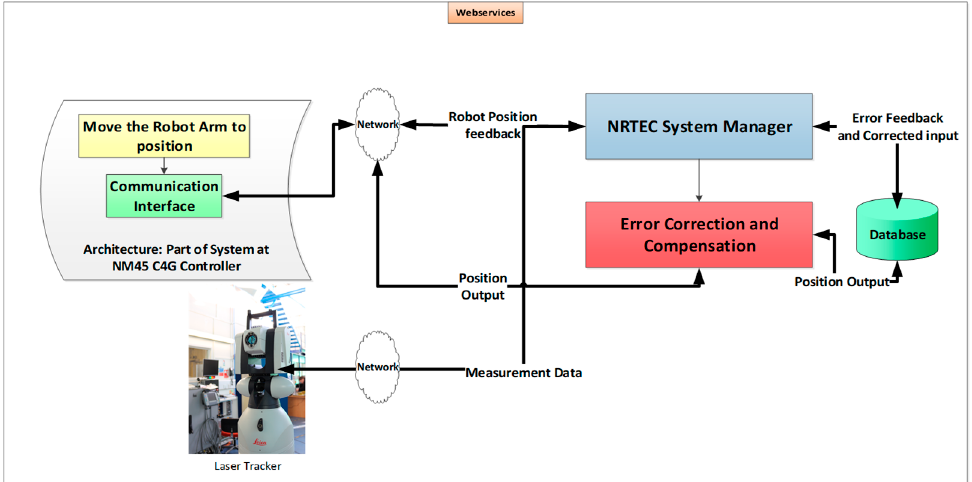
Figure 5. NRTEC basic architecture.